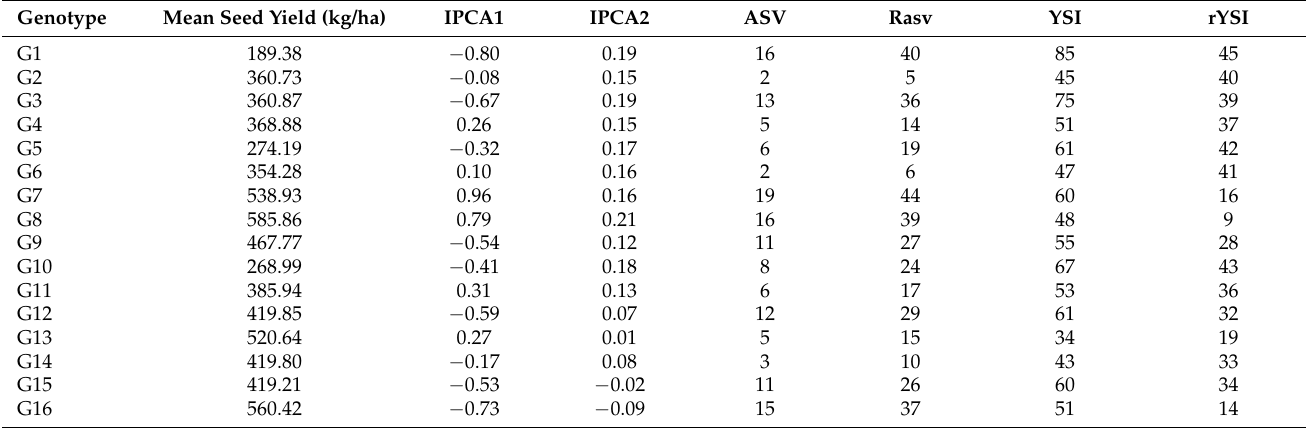
Table 7. Tepary bean accessions ranked based on seed yield, AMMI stability value, and yield stability index when evaluated across four test environments in